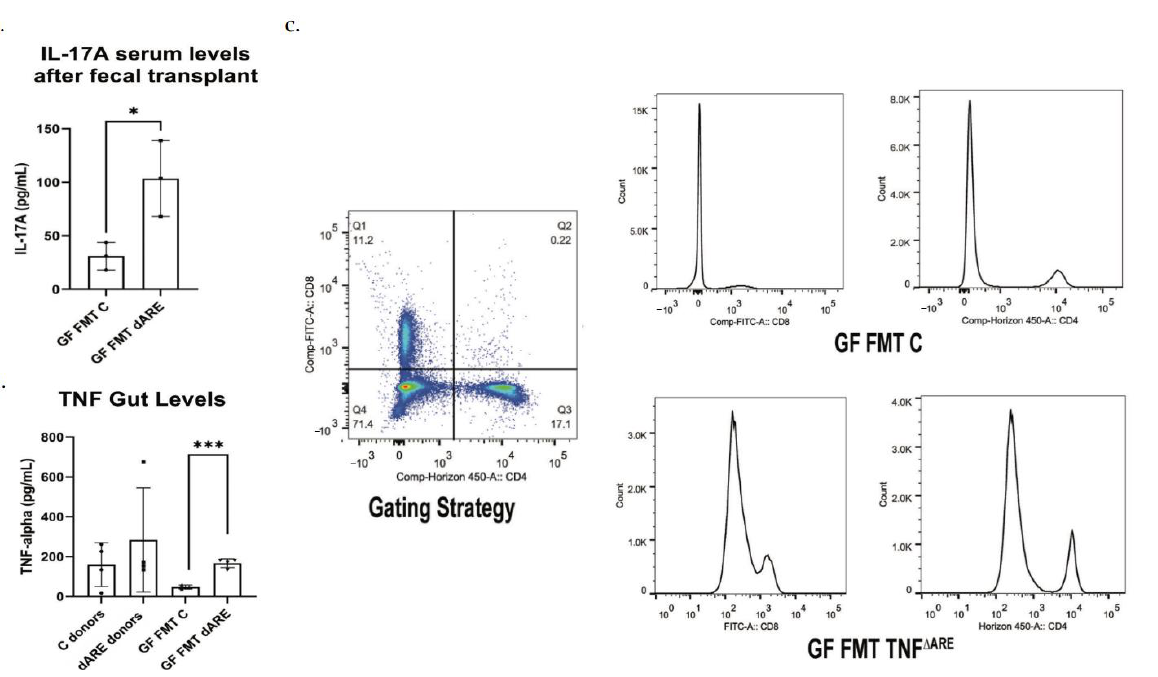
Figure 3. Proinflammatory cytokines measurement and inflammation evaluation by flow cytometry. GraphPad Prism was used to generate the bar plots, that shows the mean of data and error bars show standard deviation. Stars represent significance (* for p < 0.05 and *** for p < 0.001). Multiplex ELISA Assay (Luminex). ( a ) Multiplex assay was conducted on the serum, with antibodies against TNF, IL-1 β , IL-6 and IL-17. Results show a serological statistically significant ( p = 0.0290) increase in IL-17A level in serum of GF mice FMT with TNF ∆ ARE+/ − donors ( n = 6) compared to their controls, GF mice FMT with C donors ( n = 3). No significant difference was detected in serum TNF, IL-1 β and IL-6 levels. Results were similar between males and females and were representative of the colony. ( b ) The multiplex assay was conducted at the tissue level after gut protein extraction. TNF levels were significatively elevated in TNF ∆ ARE+/ − donors ( n = 4) compared to control donors ( n = 4). TNF levels were below the limit f detection in healthy control mice donors. The levels of TNF were significatively elevated in GF mice FMT with TNF ∆ ARE+/ − ( n = 4) compared to GF mice FMT with C ( n = 3, p = 0.0004). ( c )—Flow cytometry was conducted on spleen cells using antibodies directed against CD4 and CD8. After gating on lymphocytes, results show an activation and expansion of CD4+ and CD8+ T cells in GF mice FMT with TNF ∆ ARE+/ − when compared to their counterpart controls, suggesting an immune response initiation and inflammatory status initiation. Data shown from n = 4 in each